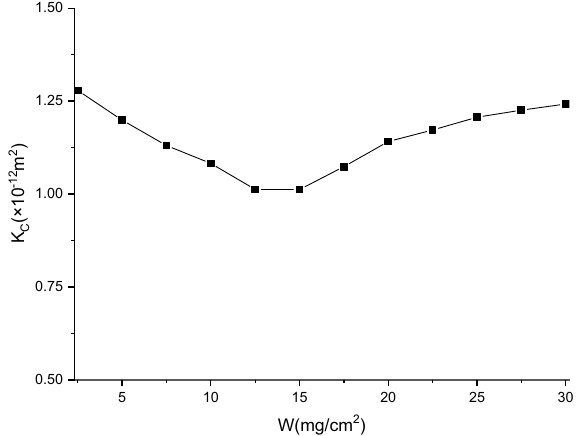
Figure 11. Change in permeability coefficient of dust cake with W during flat